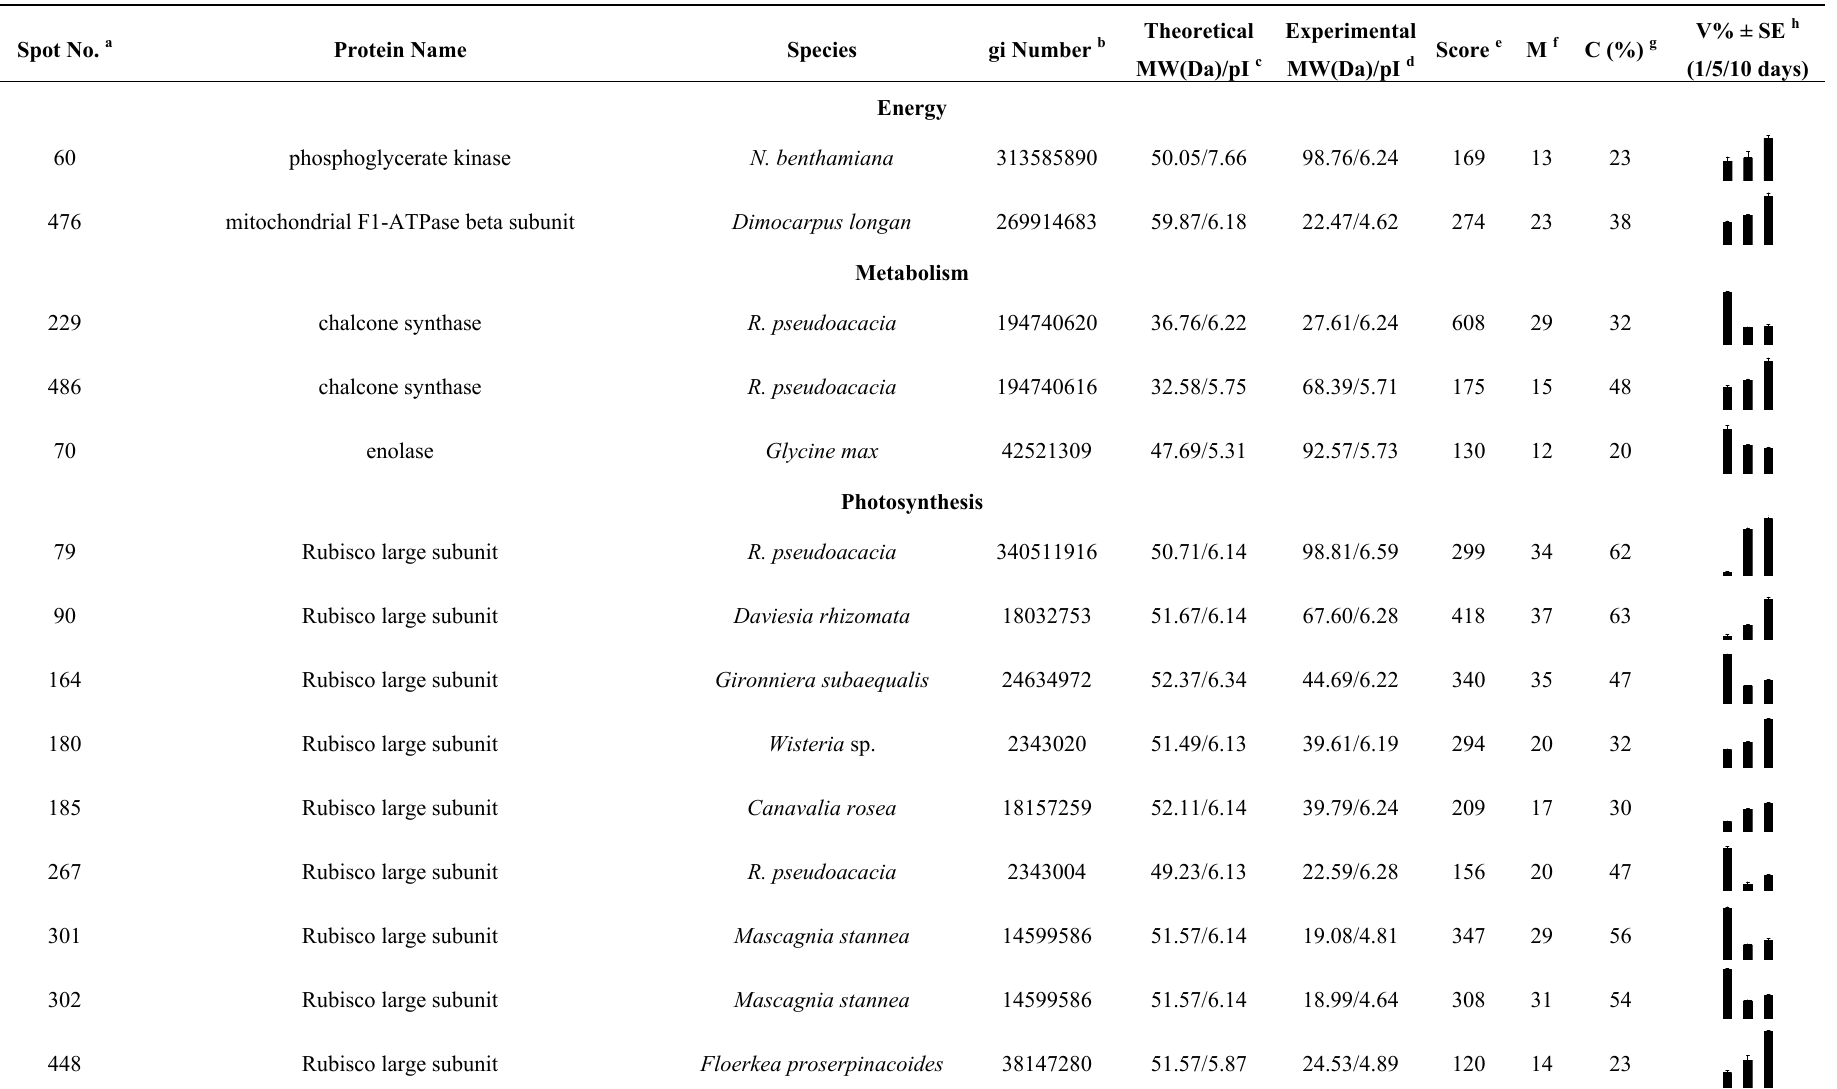
Table 2. Protein identities and their relative changes in leaves of tetraploid Robinia pseudoacacia under salt stress. Spot No.